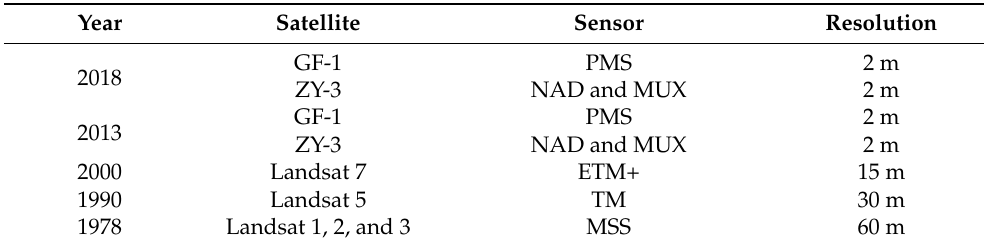
Table 2. The satellite platform and sensors used in mangrove